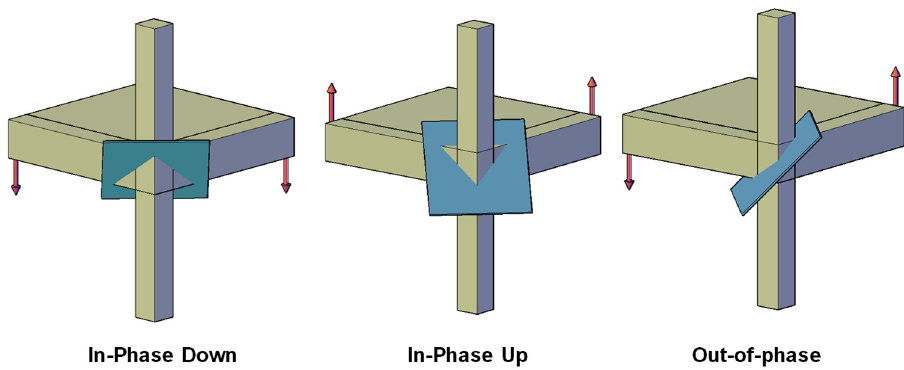
Figure 6. Orientation of the diagonal failure plane for different bidirectional loading cases.